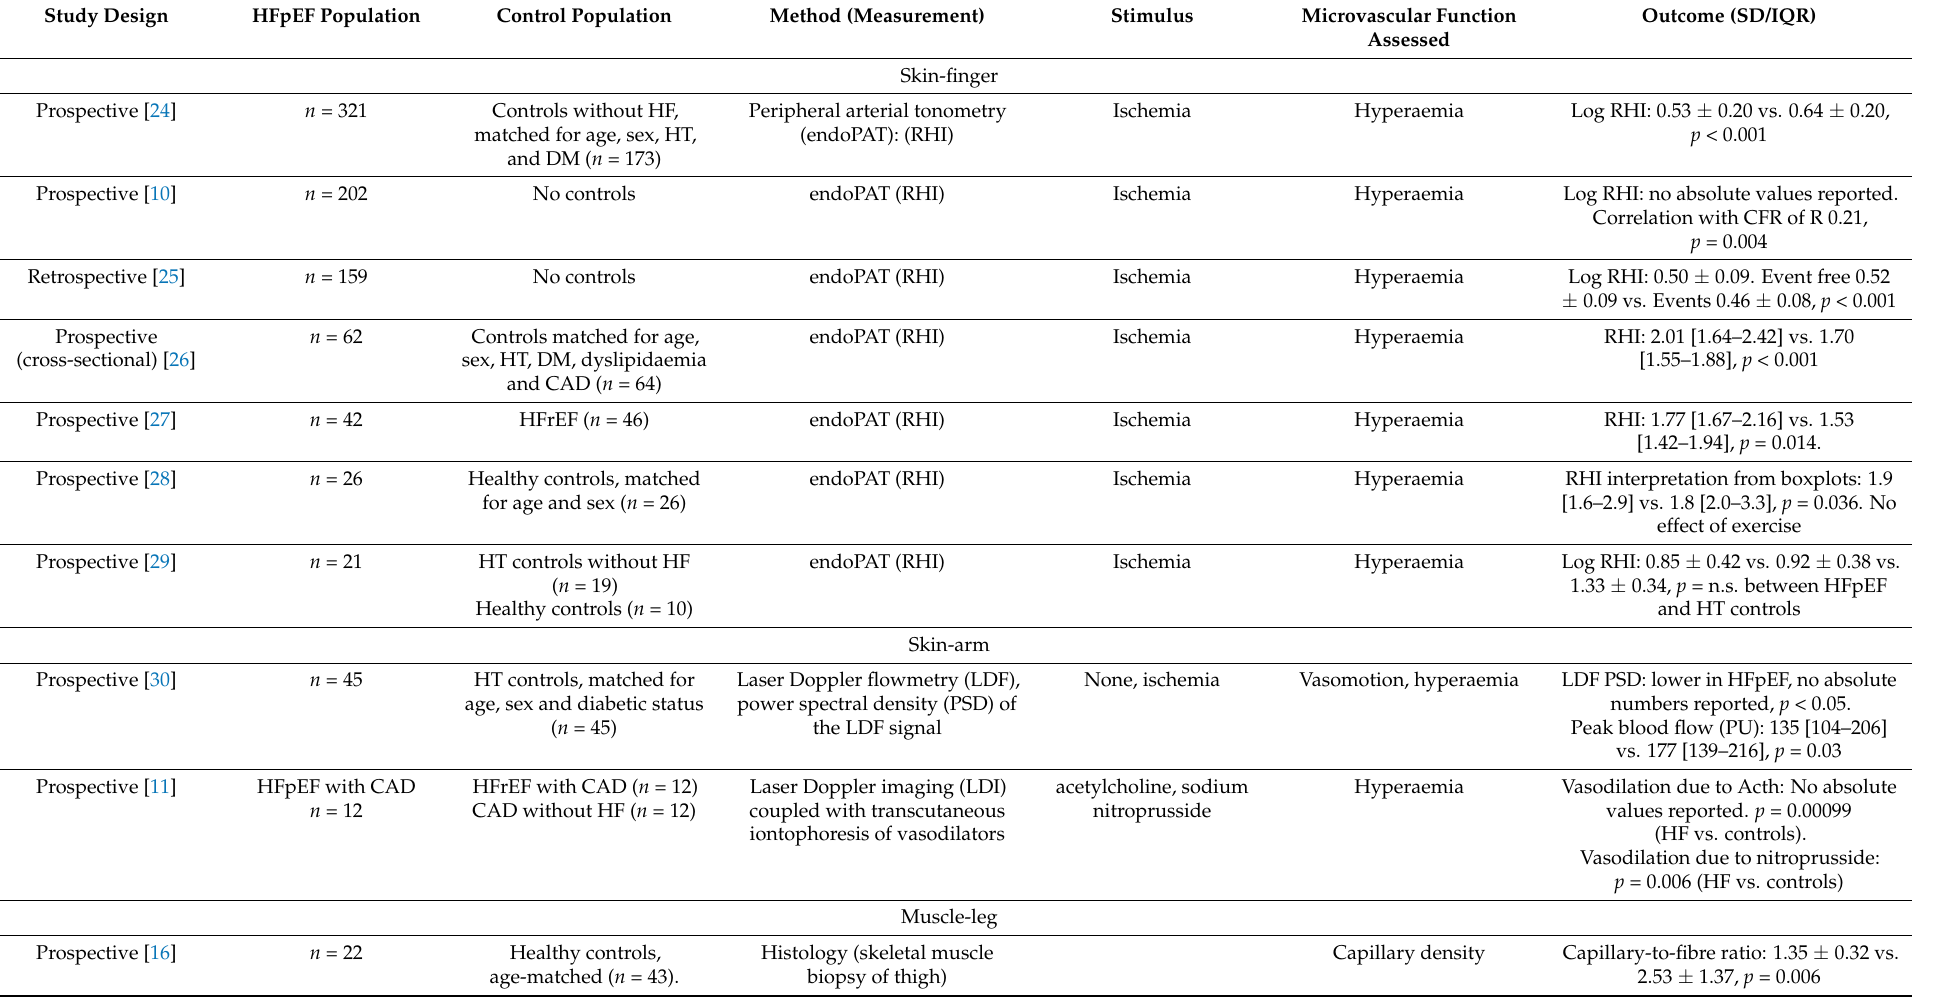
Table 1. Studies on peripheral microvascular function in